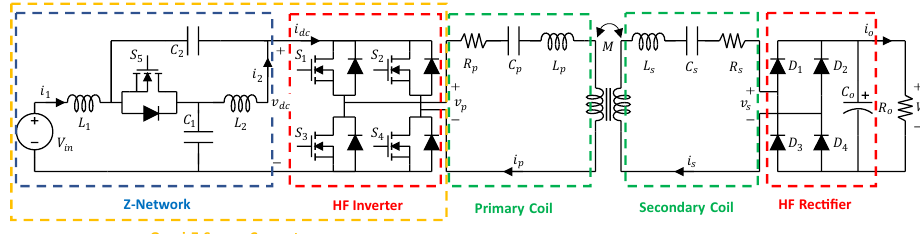
Figure 2. Circuit schematic of the qZS-based IPT system.